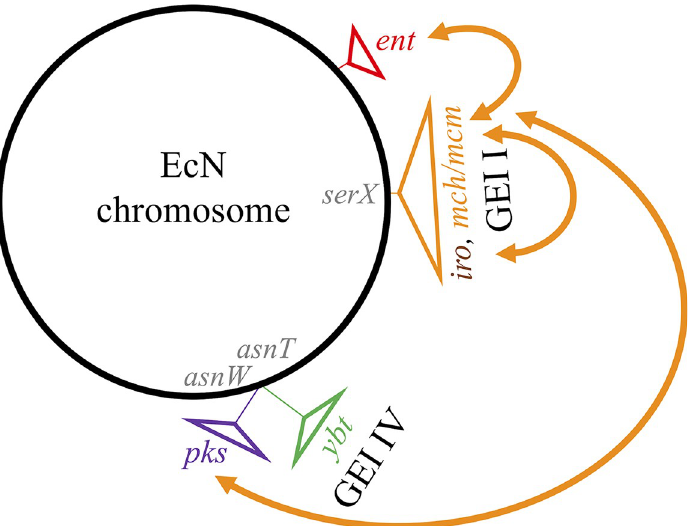
Fig 8. Gene clusters involved in the production of microcins H47 and M (MccH47 and M) in E . coli strain Nissle (EcN) represented on a genomic map. The loci that encode enterobactin ( ent ), colibactin ( pks ), yersiniabactin ( ybt ) on EcN genomic island (GEI) IV, salmochelin ( iro ) and MccH47 ( mch ) and M ( mcm ) on GEI I are represented. The arrows represent the interplays between the different gene clusters involved in MccH47 and M production in